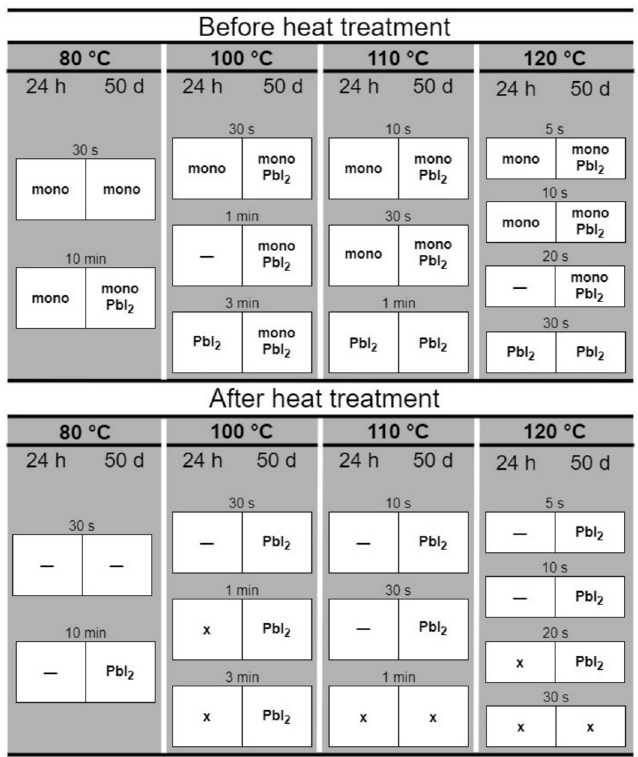
Figure 8. Evolution of extra phases in perovskite films after exposure to high humidity for 24 h and 50 days, before and after the conversion heat treatment: monohydrate (mono); PbI ; no extra phases (—); no treatment 2